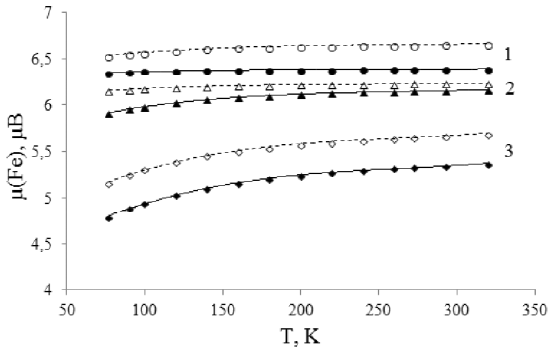
Fig. 4 . Temperature dependencies of the effective magnetic moment of iron in the Bi (dotted lines) and Bi solutions at x =0.005 (1), 0.01 (2), and 0.06 (3).